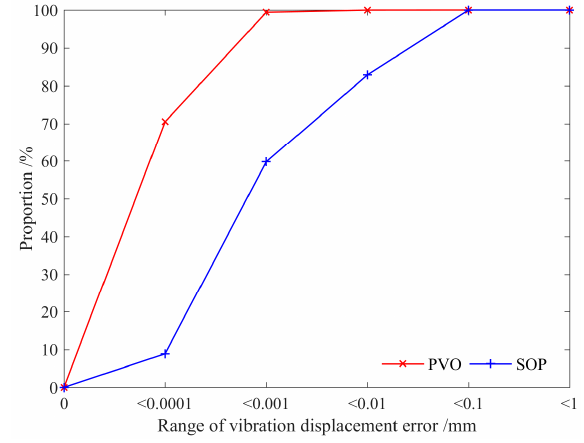
Figure 10. Proportion of vibration displacement error. Table 1. Performance comparison among SOP and PVO techniques.